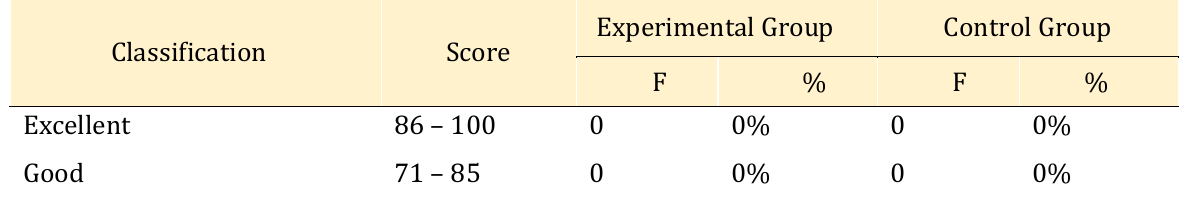
Table 2. The Frequency and Percentage o f Students’ Achievement in term o f Accuracy in